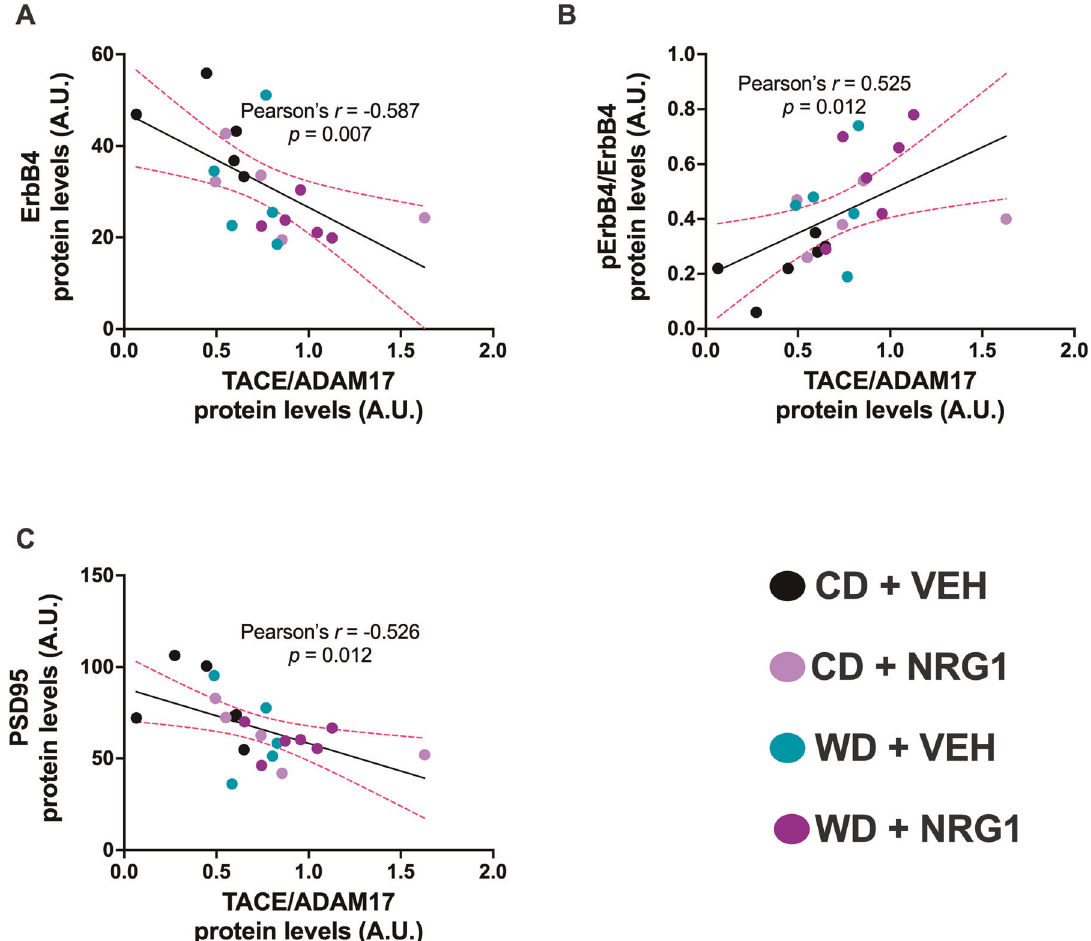
Fig. 7 TACE/ADAM17 hippocampal protein levels are associated with ErbB4 activities. A ADAM17 hippocampal protein levels negatively correlates with ErbB4 protein levels ( r = − 0.59, p = 0.007). B ADAM17 protein levels positively correlates with hippocampal pErbB4 protein levels ( r = 0.53, p = 0.012). C ADAM17 protein levels negatively correlates with PSD-95 protein levels in the hippocampus ( r = − 0.54, p = 0.012). Sample size = 5 – 6 rats/group. Sample numbers: CD + VEH, n = 6; CD + NRG1, n = 6; WD + VEH, n = 6; WD + NRG1, n =